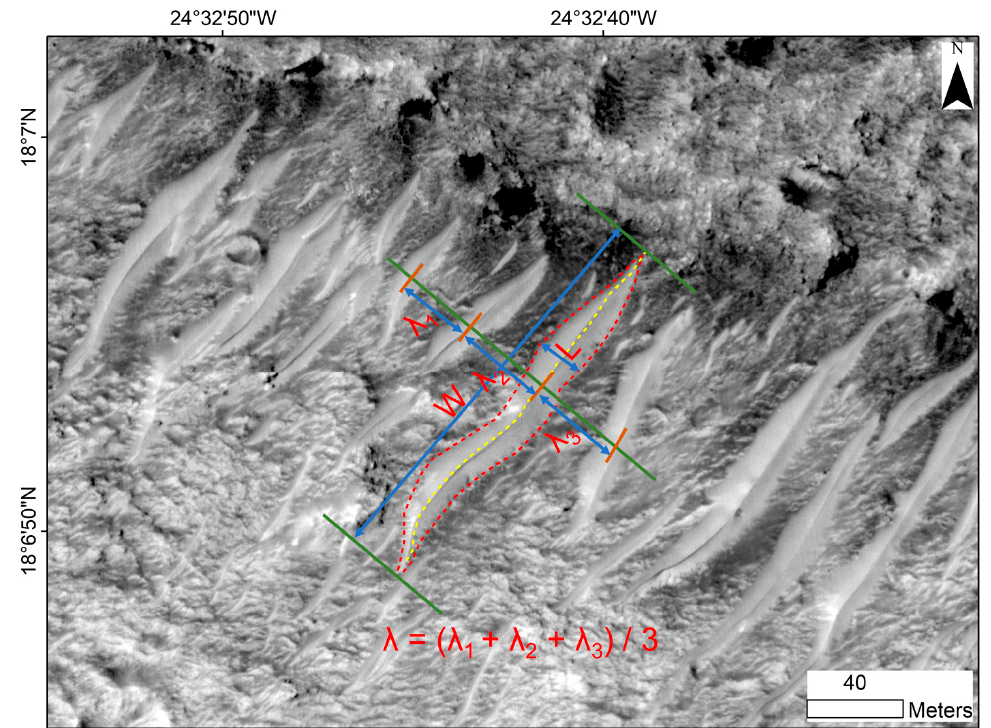
Figure 4. Elements of morphometry for transverse aeolian ridges (TARs) as seen in HiRISE image PSP_009735_1985. The red dashed curves represent the TAR boundary and the yellow curve represents the crestline. W = crest-ridge width, L = down-wind TAR length, λ = ridge-to-ridge mean spacing (wavelength). HiRISE image credit: NASA/JPL/University of Arizona.